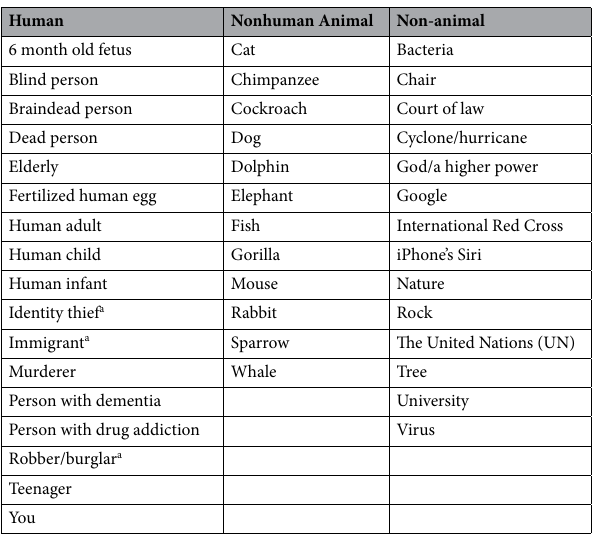
Table 1. Entities used across Studies 1, 2a, 2b, and 3. Entities marked with a were used in Study 3 only. Terms here reflect the verbal labels that accompanied each visual depiction.